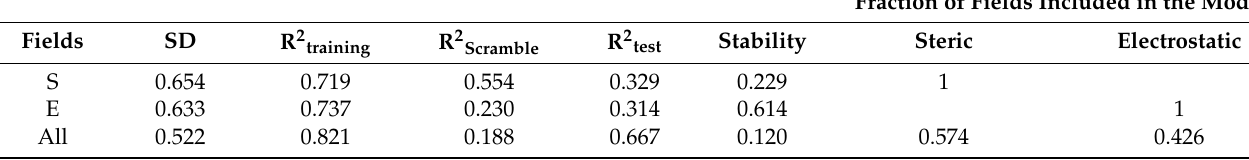
Table 1. Summary of statistical results from force field quantitative structure-activity relationship (FFQSAR) and field contributions.